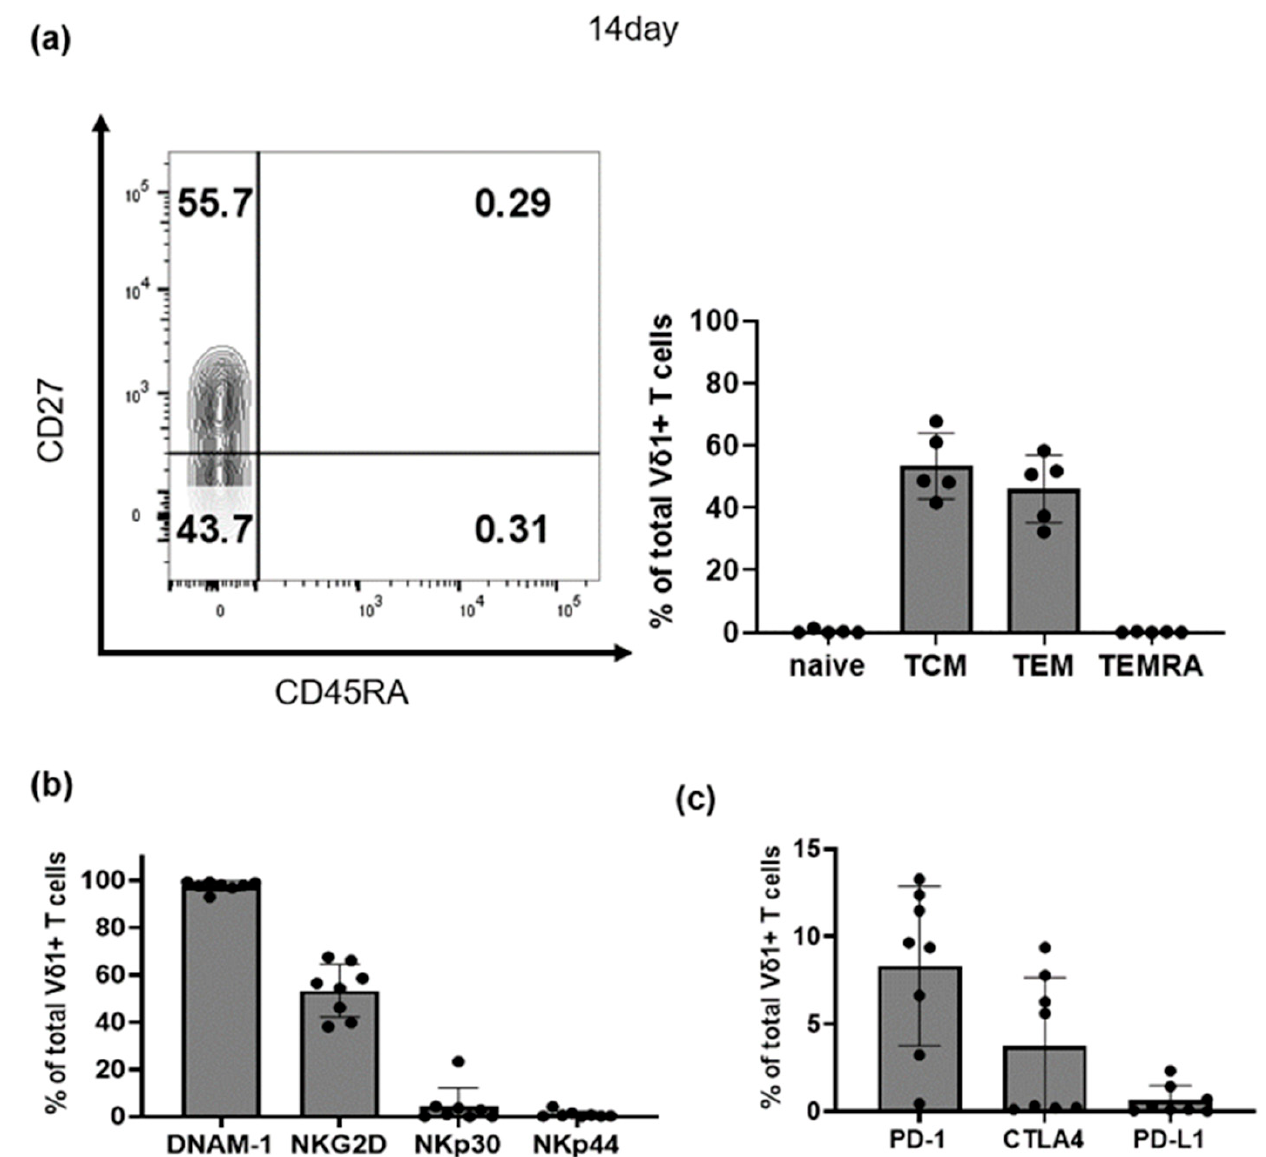
Figure 3. Immunologic memory and cytolytic markers on V δ 1+ T cells. ( a ) Representative flow cytometry plots showing CD27 and CD45RA expression with gates indicating Naïve (CD45RA+CD27+), central memory (TCM, CD45RA-CD27+), effector memory (TEM, CD45RA- CD27 − ), and CD45RA+ terminal effector memory cells (TEMRA, CD45RA+CD27 − ) V δ 1+ T cells on day 14. Frequency of TEMRA, effector memory, central memory, and naïve V δ 1+ T cells shown as a percentage of all V δ 1+ T cells ( n = 5). ( b ) Expression of activating receptors and ( c )